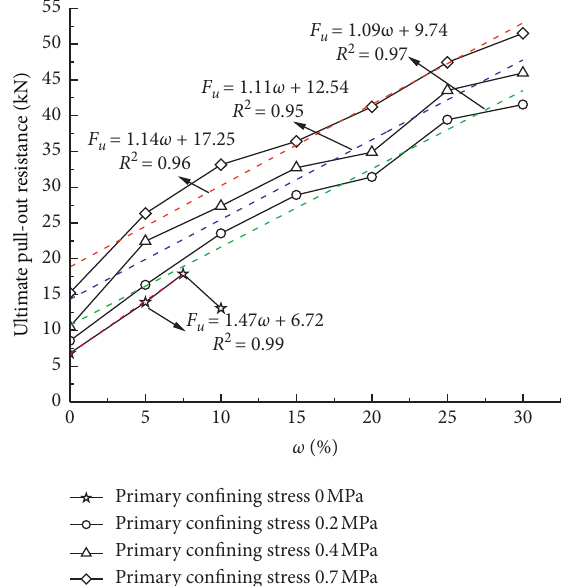
Figure 18: Variation of ultimate pull-out resistance with the expansion agent content under different initial confinement